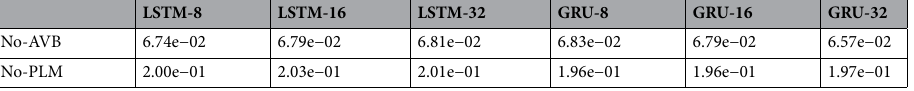
Table 4. The average RMSE of ten simulations obtained with the LSTM and GRU with different sizes, when trained without input information of the AVB or PLM neurons.